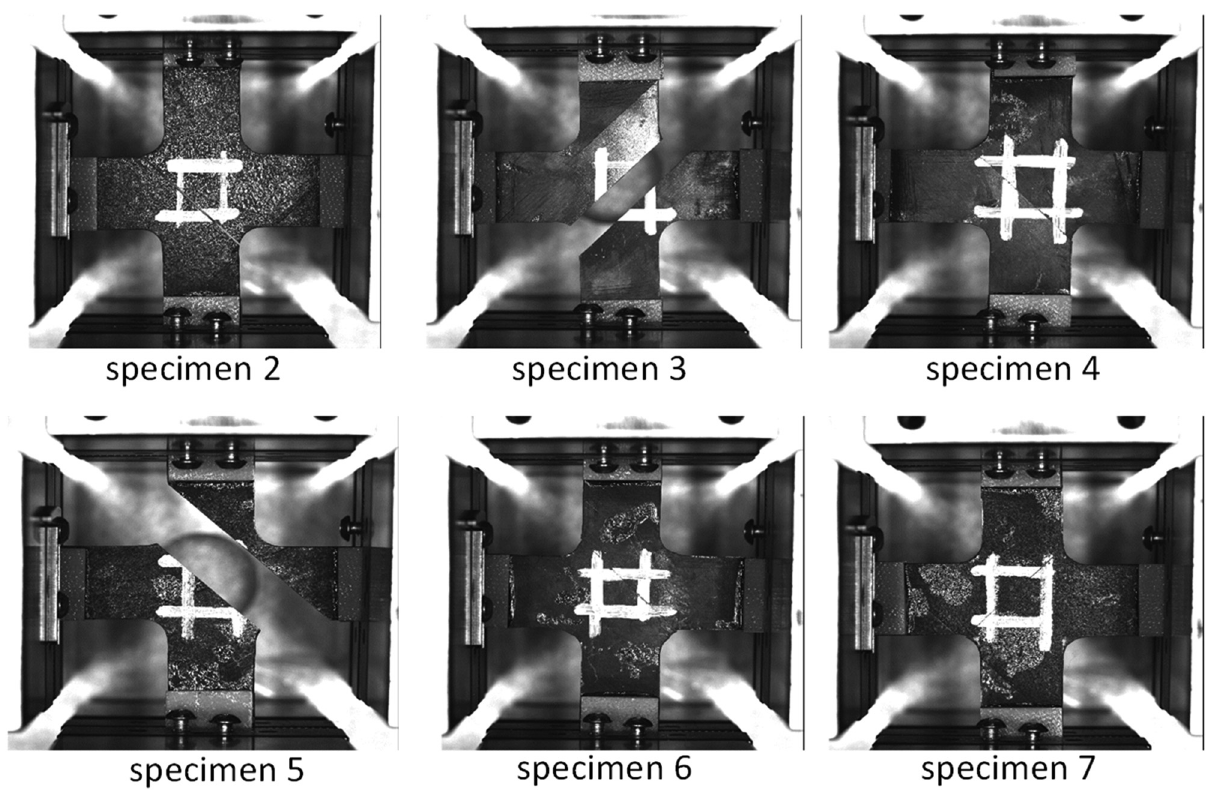
Figure 8: Failures of the biaxial test